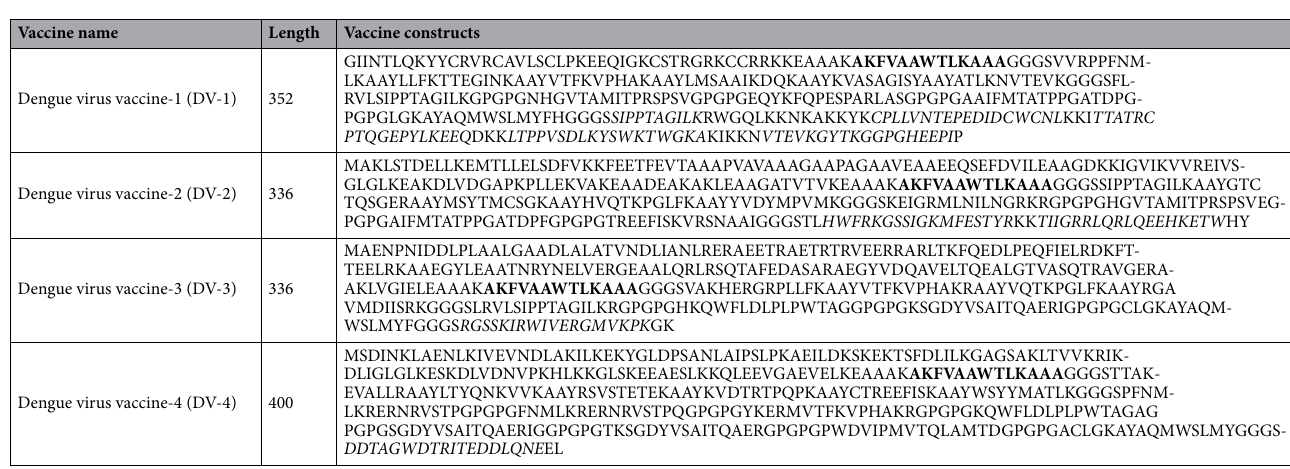
Table 7. Predicted multi-epitope based vaccines. The distinct bold sequences are the pan HLA DR-binding epitope (PADRE) while the B cell epitopes are italicized.